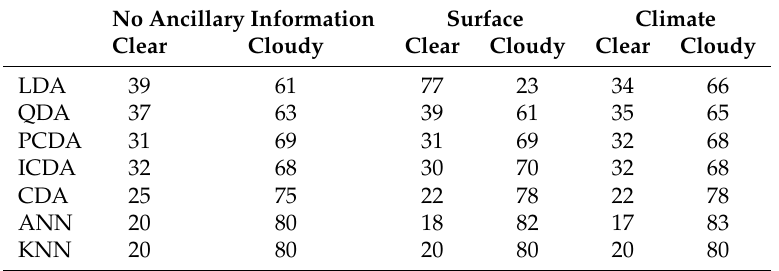
Table 12. Percentage of semi-transparent clouds detected as Clear or Cloudy by classification methods in the three classification configurations (no ancillary information; with surface information; with climatic information). The total number of semi-transparent scenes in the gold standard dataset is 438. No Ancillary